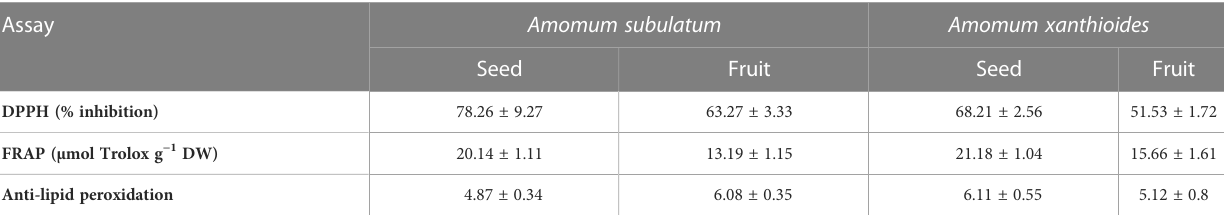
TABLE 2 Antioxidant activity exhibited by Amomum subulatum and Amomum xanthioides extracts.